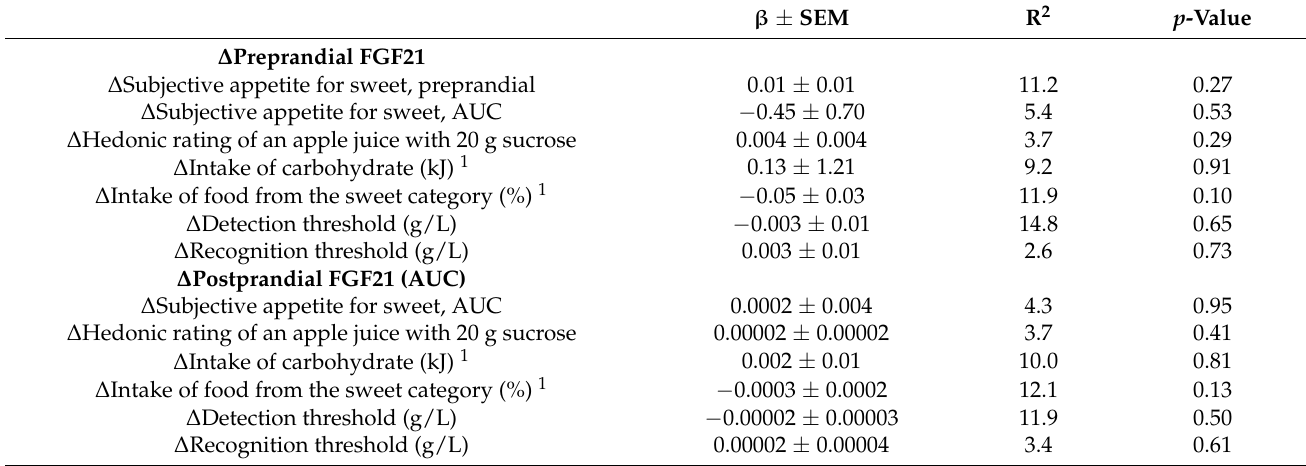
∆ Subjective appetite for sweet,